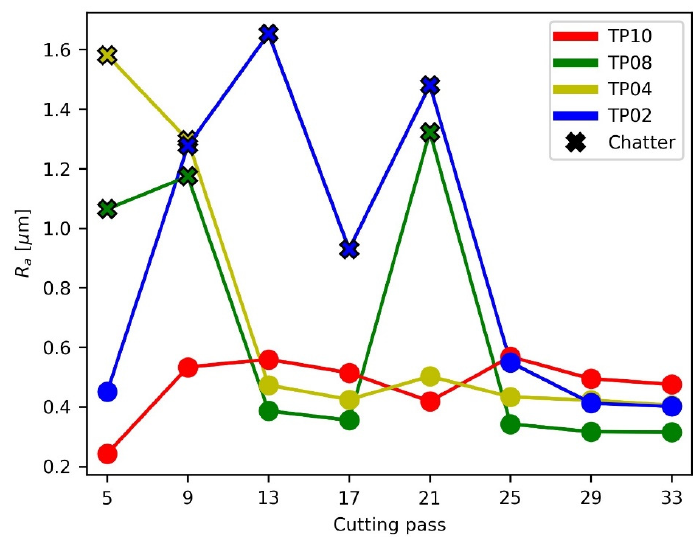
Figure 10. Average roughness per cutting